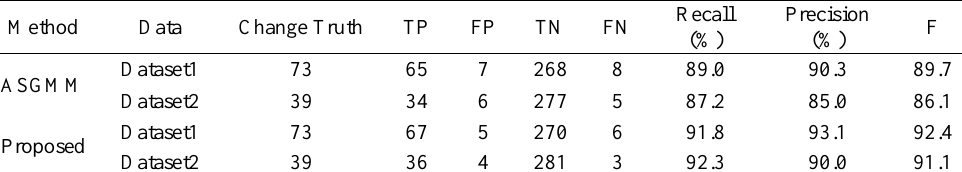
Table 6. Quantitative results of change detection